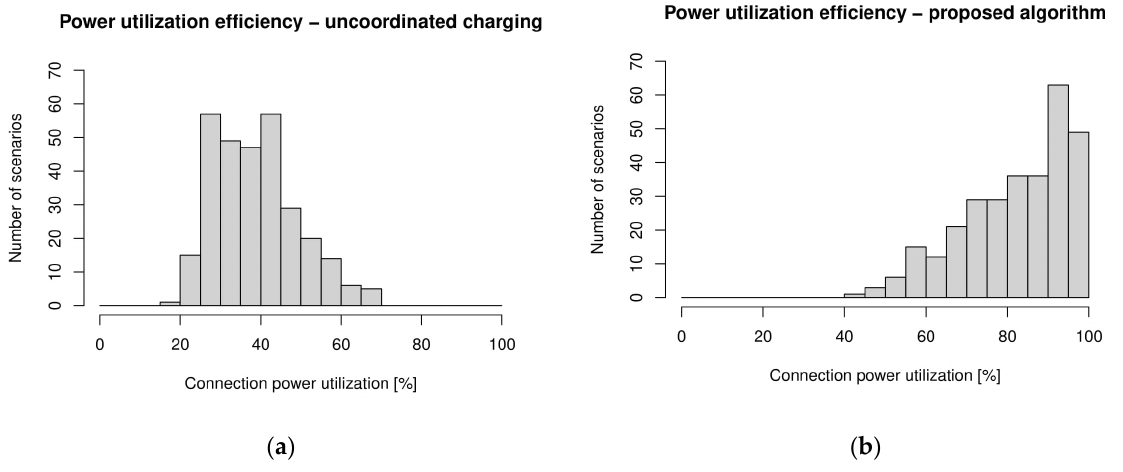
Figure 8. A summary of simulated scenario duration. ( a ) Without the proposed algorithm. (b) With the proposed algorithm.